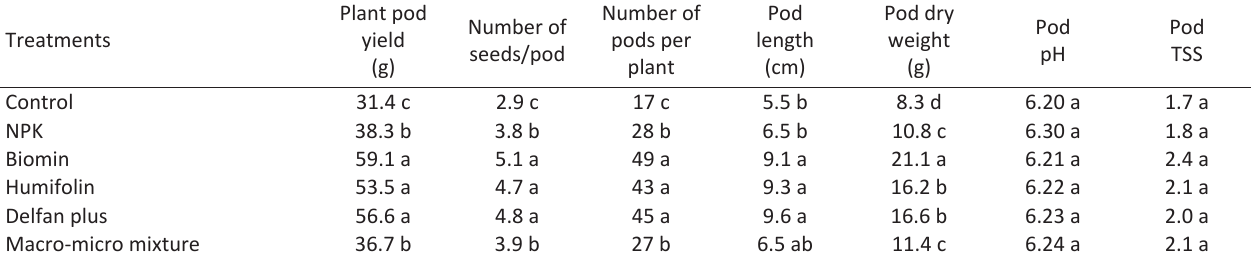
Table 2 - Effects of various fertilization treatments on vegetative growth traits of French bean plants in a calcareous soil under field con- ditions